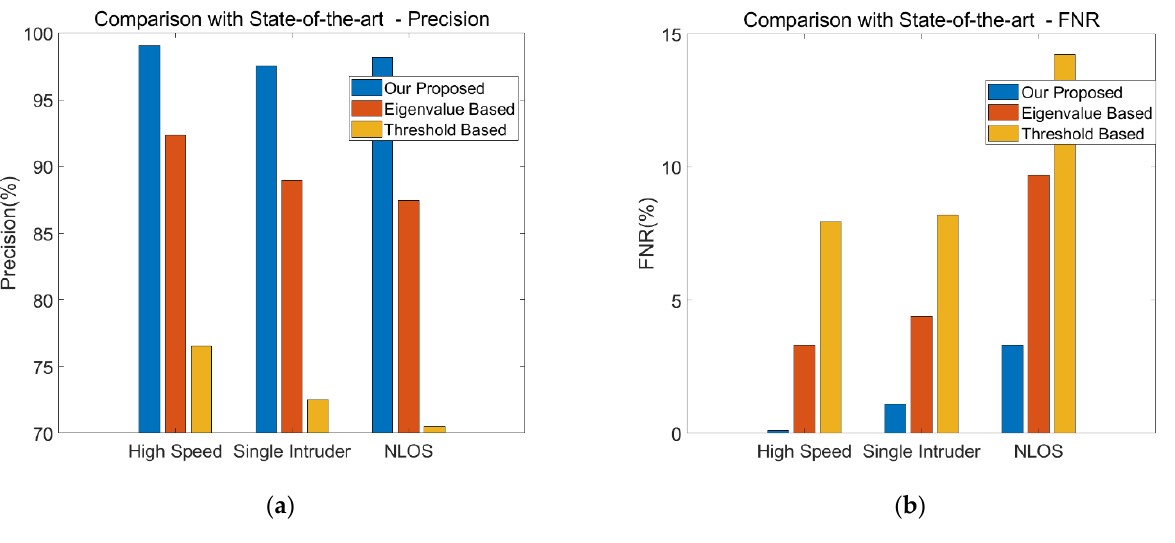
Figure 22. Comparison with other methods. ( a ) Precision. ( b ) FNR.